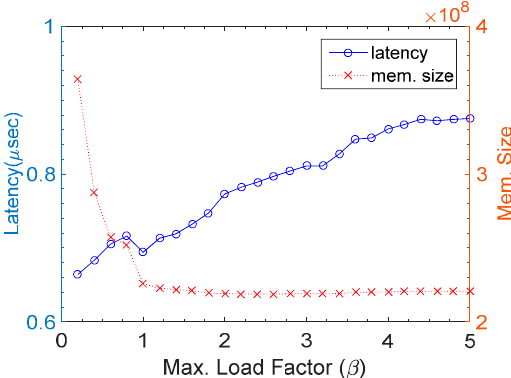
Figure 10. The lookup latency and required memory size.